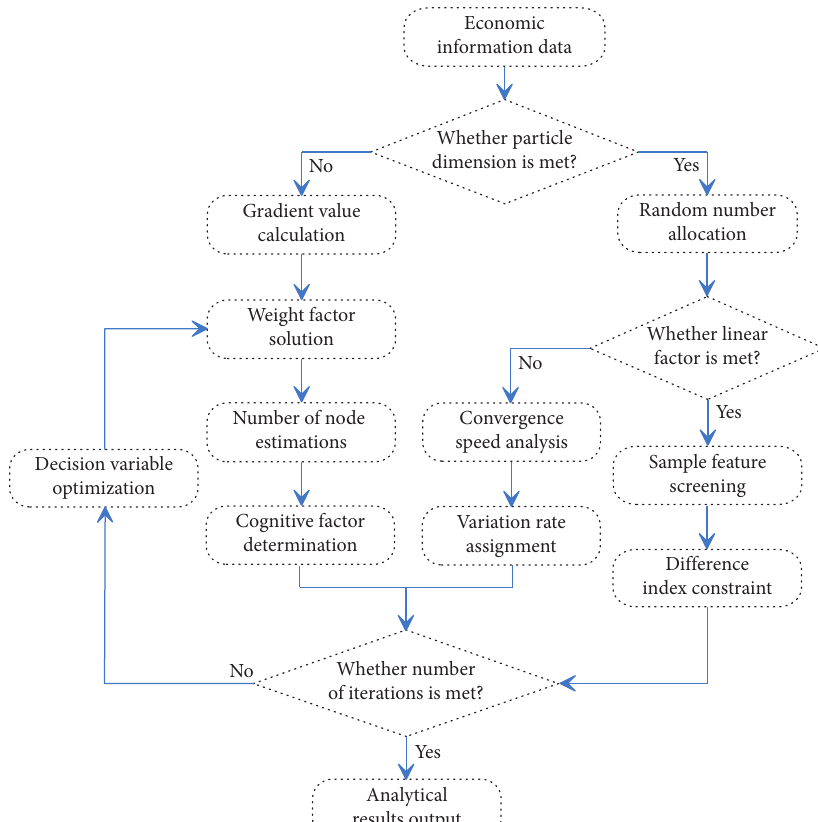
Figure 2: Analytical flowchart of regional economic development difference based on intelligent hybrid